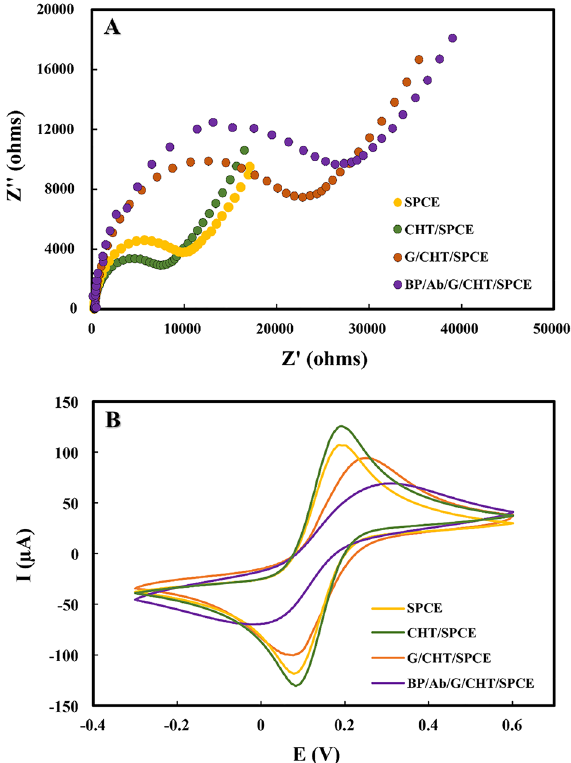
Figure 1. ( A ) Nyquist plots and ( B ) cyclic voltammograms of SPCE, CHT/SPCE, G/CHT/SPCE, and BP/Ab/G/ CHT/SPCE using 5 mM [Fe(CN) 6 ] 3−/4− in 0.1 M